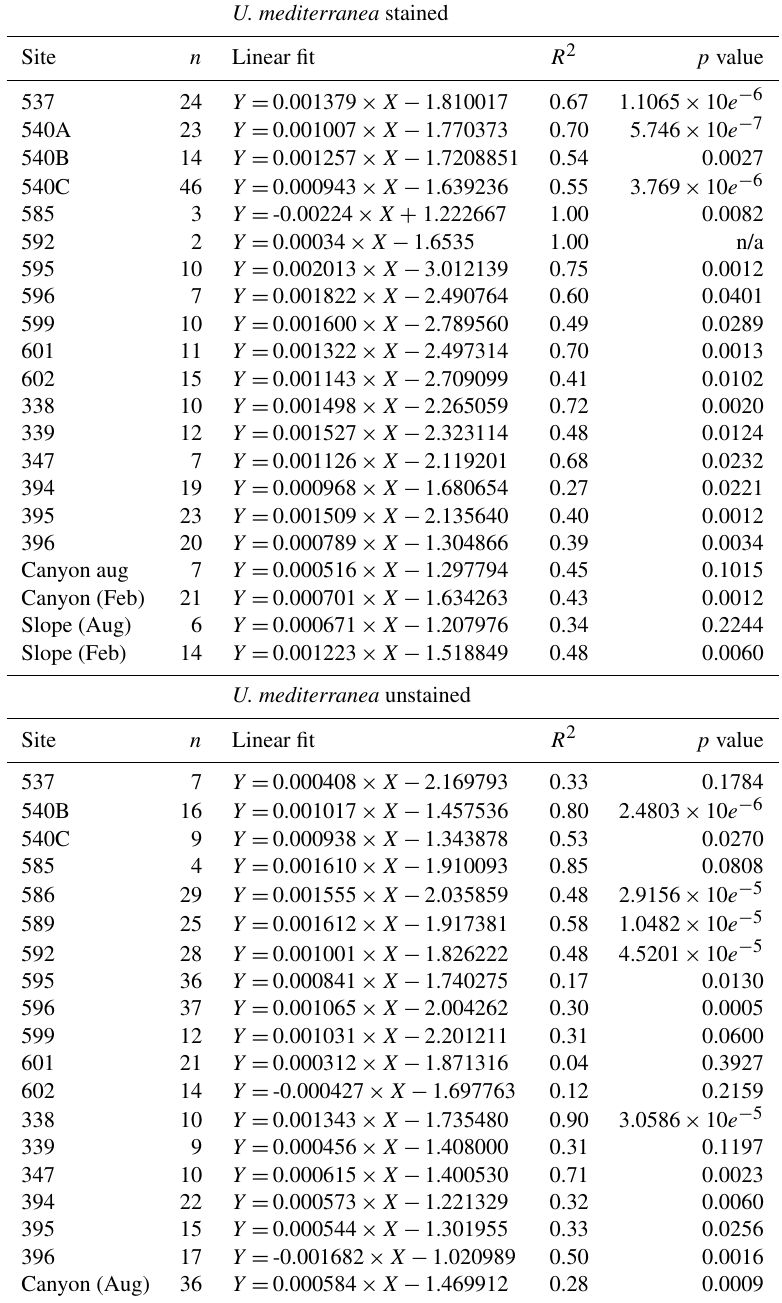
Table 3. Linear regressions of ontogenetic trends of δ 13 C Umed . The measured number of stained and unstained tests as well as the significance values are